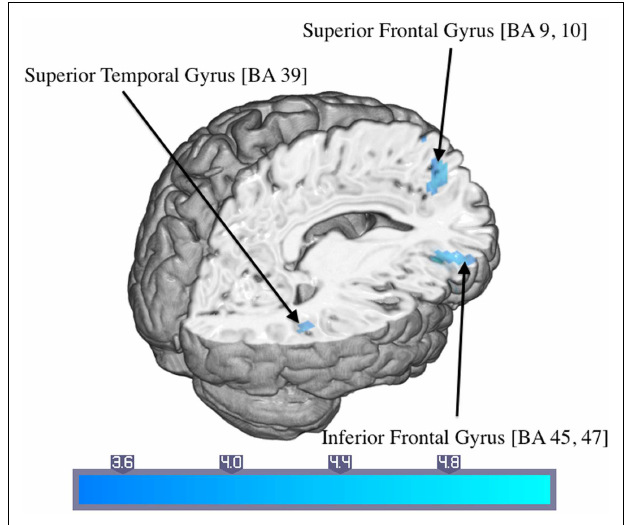
FIGURE 4 | Significant activations of the response to trauma-related compared to neutral pictures in the control group (numbers in brackets indicate Brodmann areas)